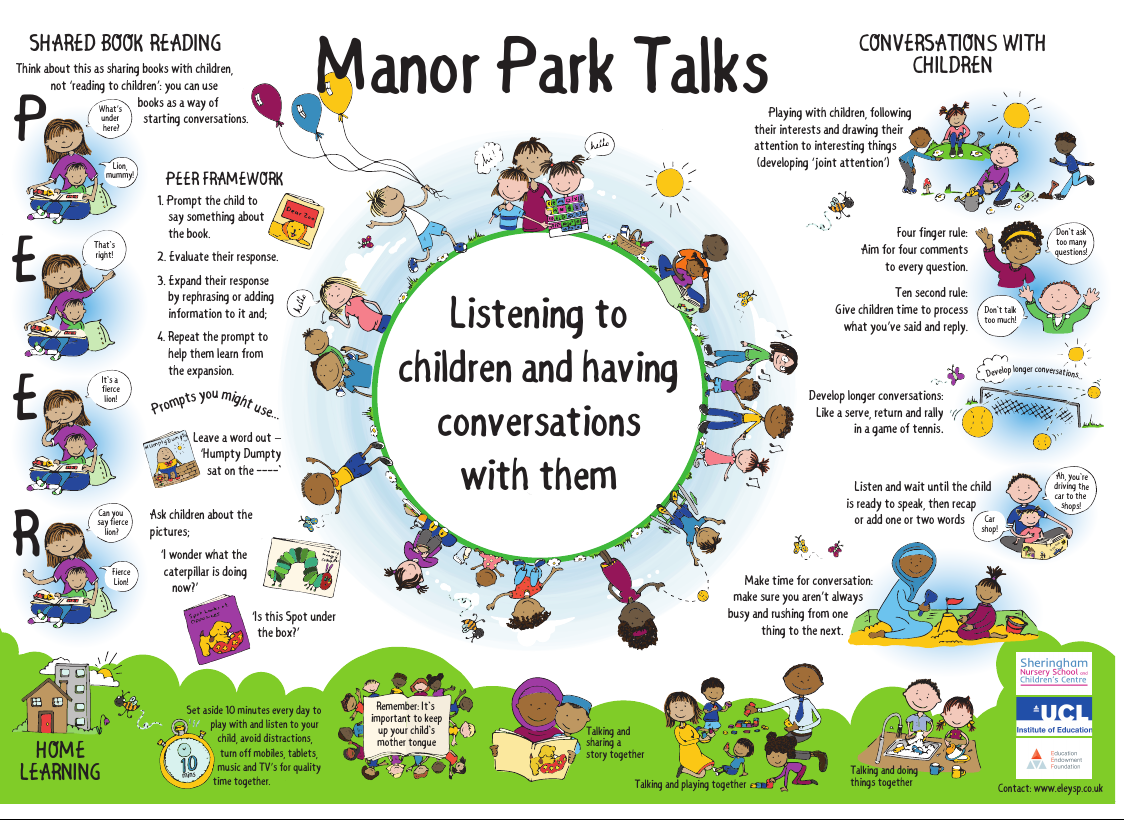
Figure 2. Poster 2 (Source: authors)